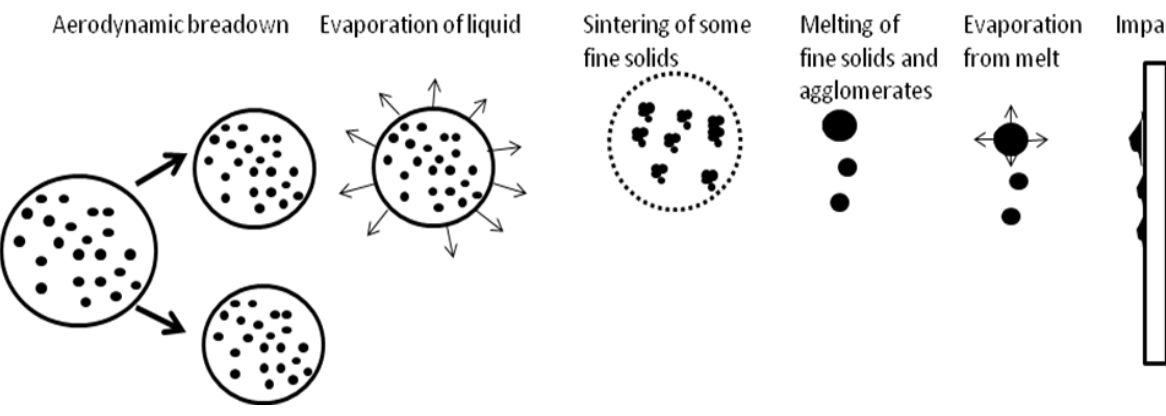
Figure 16 . Evolution of a suspension droplet in the high temperature plasma or flame